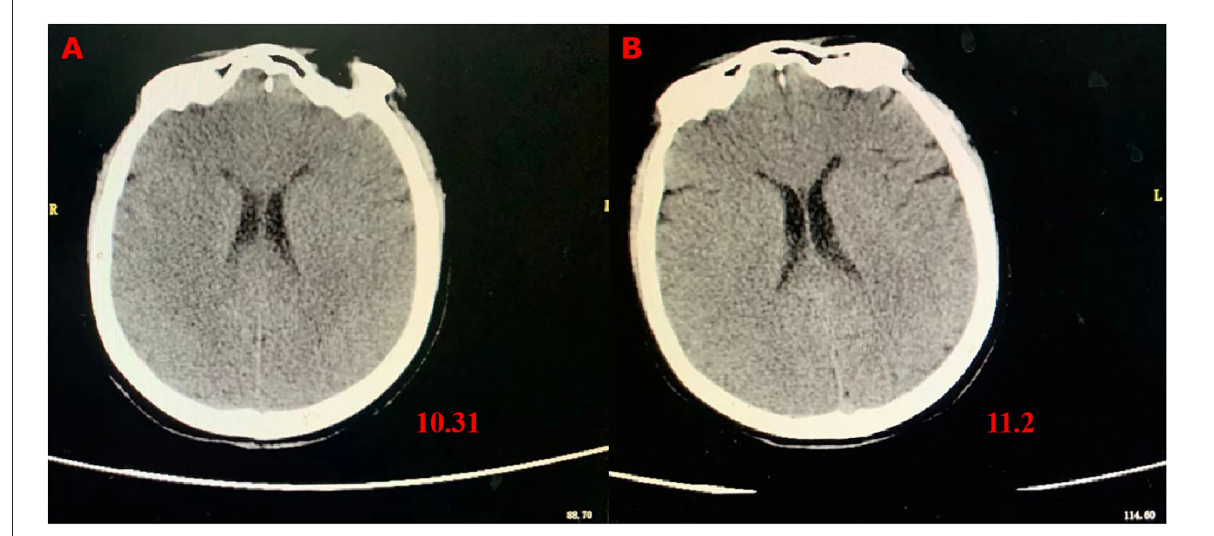
FIGURE2 Skull CT images showing brain edema. (A) CT scans at 72h after admission; (B) CT scans on the fourth day after transferring out of the ICU.